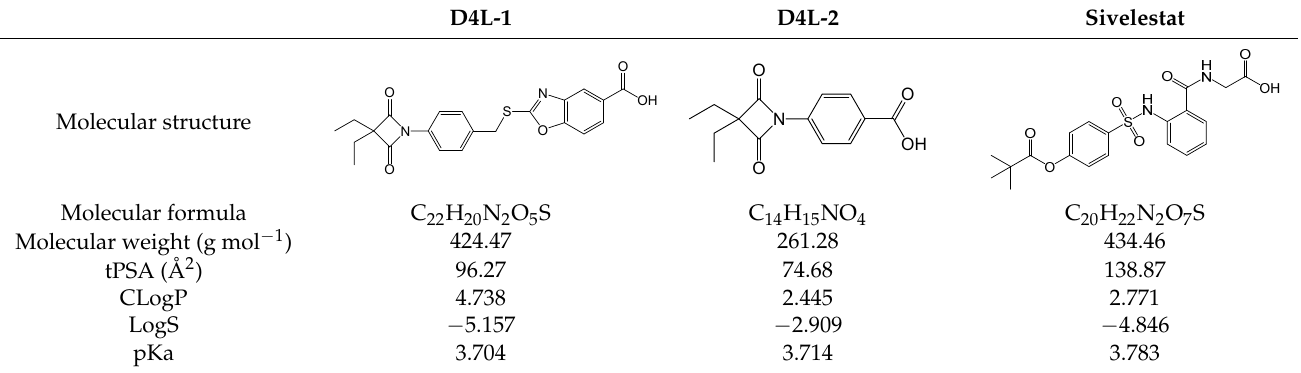
Table 1. Chemical characteristics of D4L-1, D4L-2, and Sivelestat.